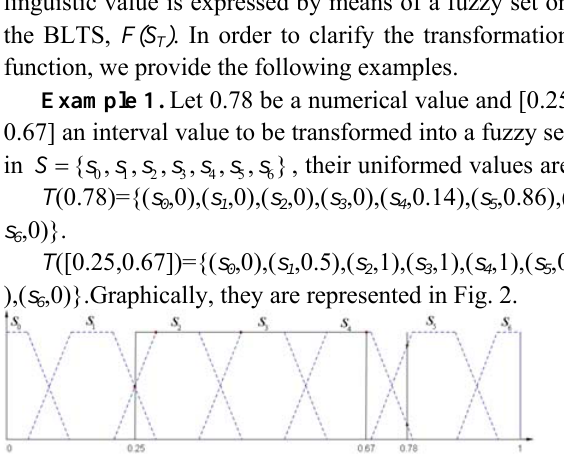
Fig. 2. The results of numerical value 0.78 and interval value[0.25,0.67] are transformed into a fuzzy set in S T